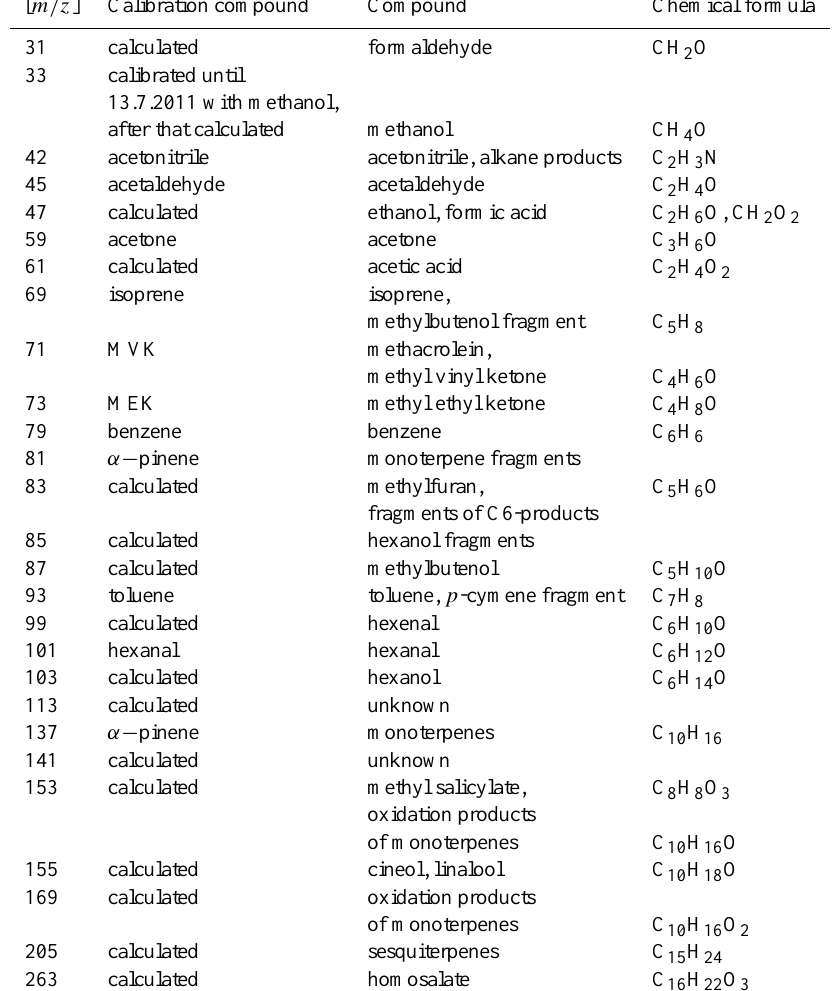
Table 1. The compound names and the formulas listed below in third and fourth column, respectively, are educated estimates for the measured masses (see e.g. de Gouw and Warneke, 2007). However, other compounds also might have a contribution at the measured masses (e.g. m/z 85, see Park et al., 2013). The second column shows whether a sensitivity was determined directly from the calibration or not (derived from a transmission curve, i.e. calculated), and which compounds were used in the